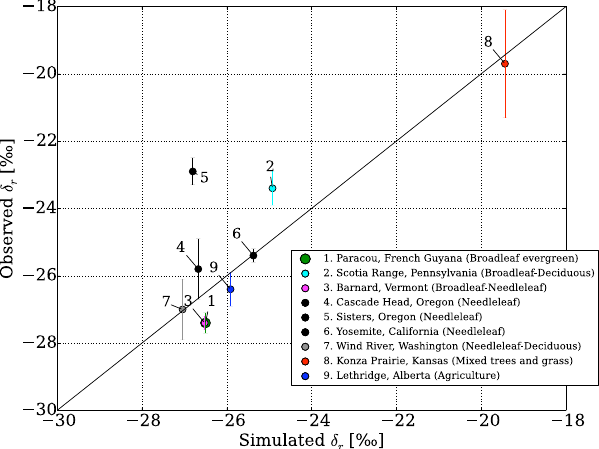
Figure 7. Measured and modeled signature of respiration at nine different sites in North and South America. The measurements are from the BASIN network (Pataki et al., 2003) and were taken in the 1980s and 1990s in the spring and summer months. Each reported value in the figure represents the mean and 1 σ standard error over a number of separate measurements which were performed at each particular site, and each simulated value was averaged over the same measurement period. The colors indicate the type of biome each site is part of. Overall, our mean simulated respiration signatures com- pare well with the observations. Outliers seen in this figure might indicate differences between the prescribed carbon turnover and the actual carbon turnover. It could also indicate SiBCASA’s inability to capture drought events that could cause a larger seasonal change in the respiration